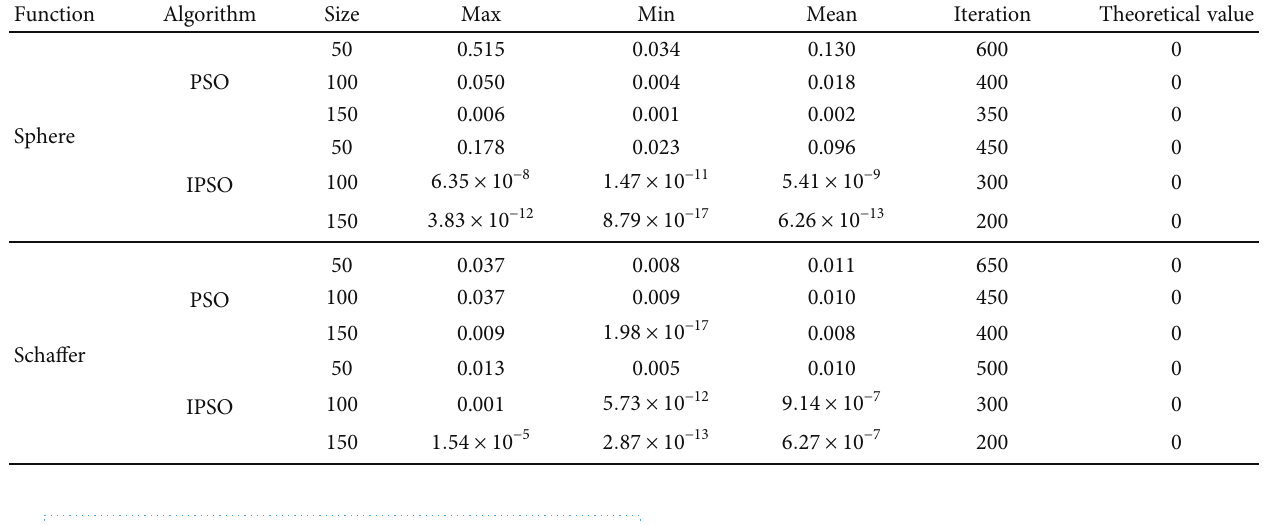
Table 2: Test results of di ff erent test functions.